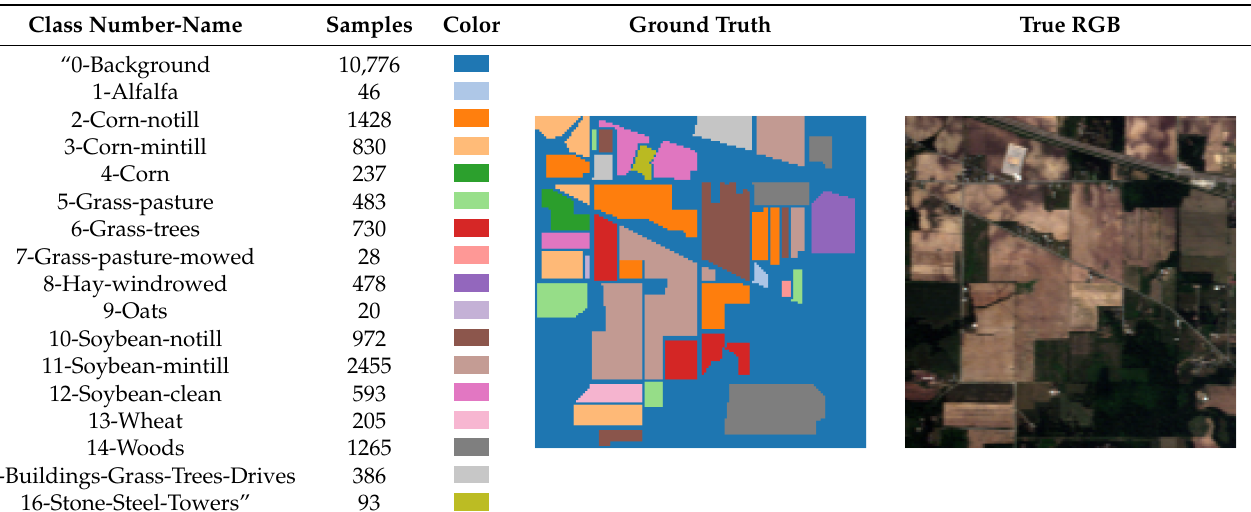
Table 4. Indian Pines ground truth description and true RGB visualization, from